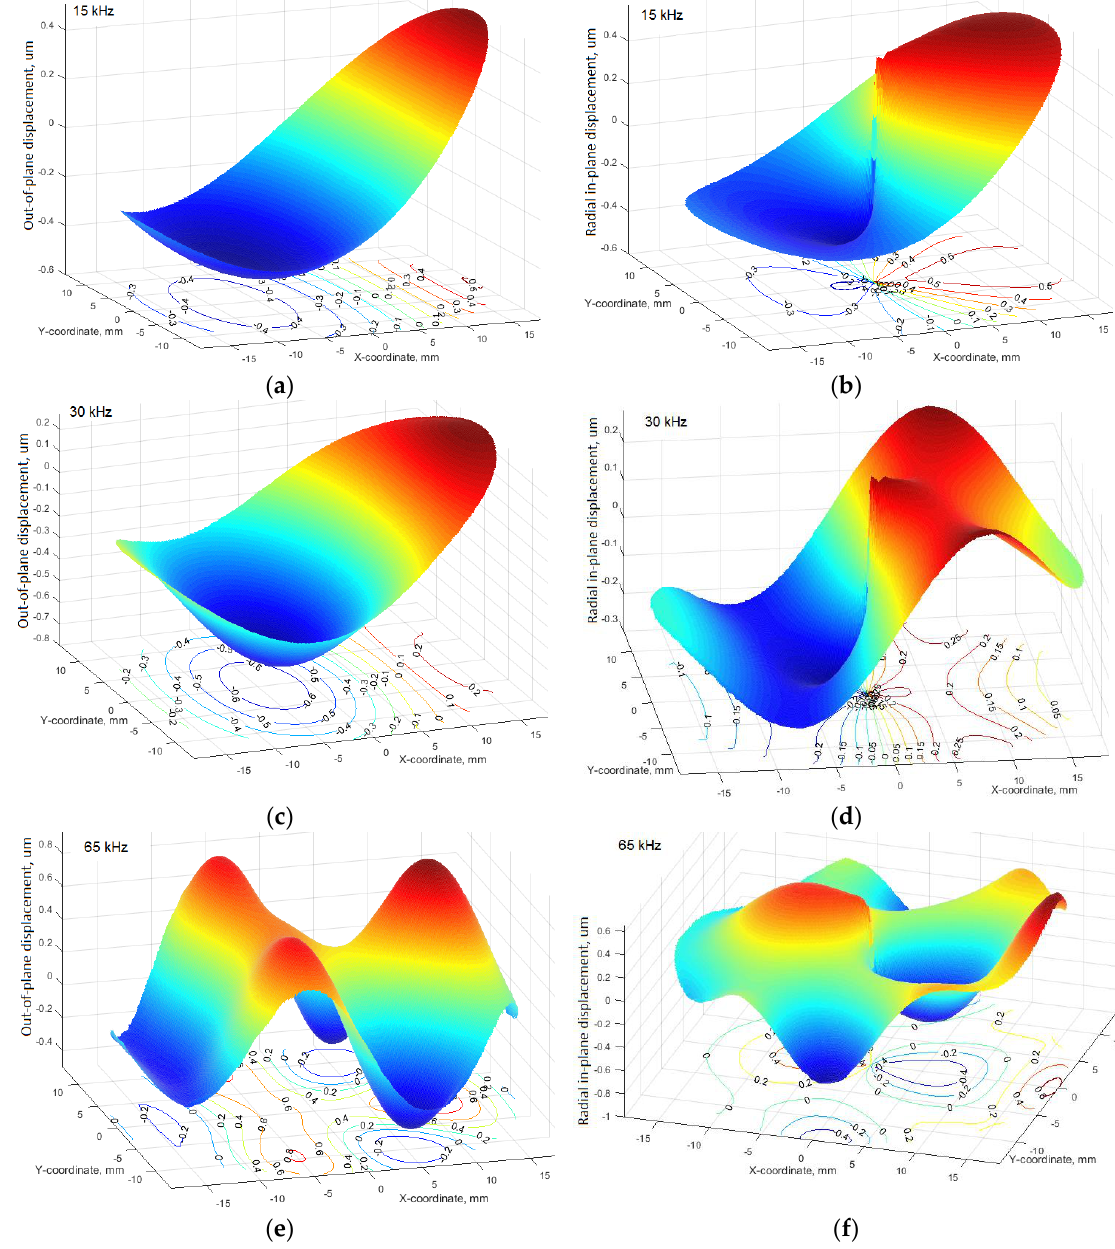
Figure 9. The radial distributions of the out-of-plane ( a , c , e ) and in-plane ( b , d , f ) amplitude displacements under footprint of angle beam wedge actuator exciting the studied plastic panel at the excitation frequencies 15 ( a , b ), 30 ( c , d ), and 65 kHz ( e , f ).